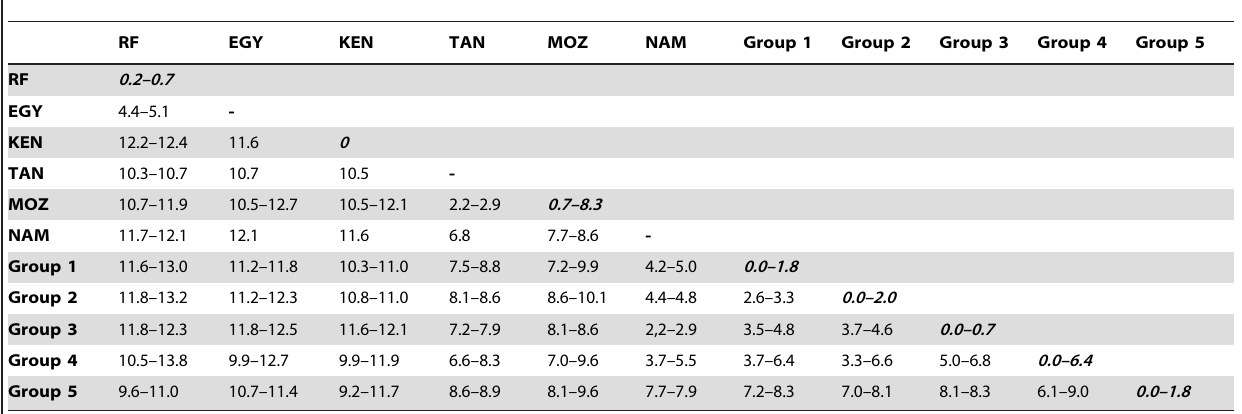
Table 2. Uncorrected pairwise distances (%) between R. ferrumequinum (RF) and R. clivosus s.l. from Egypt (EGY), Kenya (KEN), Tanzania (TAN), Mozambique (MOZ), Namibia (NAM), and the five South African groups (see Fig. 2. Bold, italic values in the diagonal indicate within group distances and hyphens indicate n